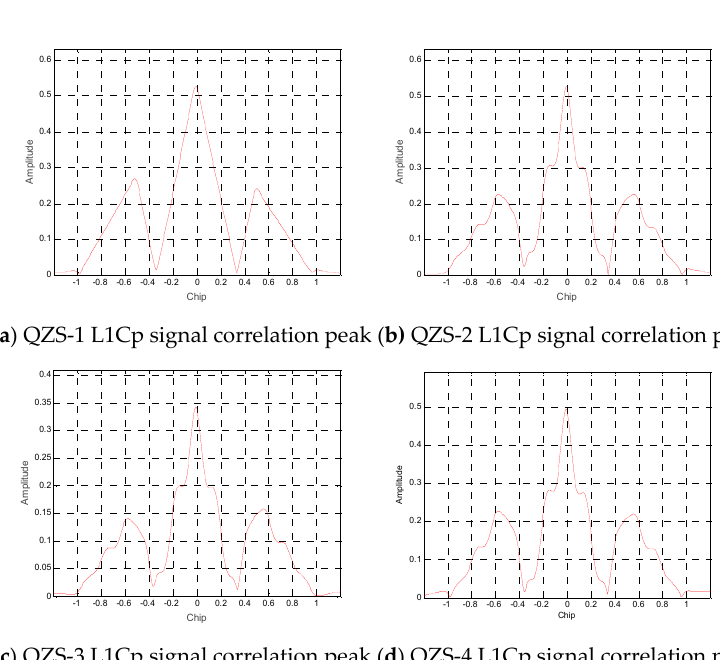
Figure 6. QZSS satellite L1Cp correlation peak.